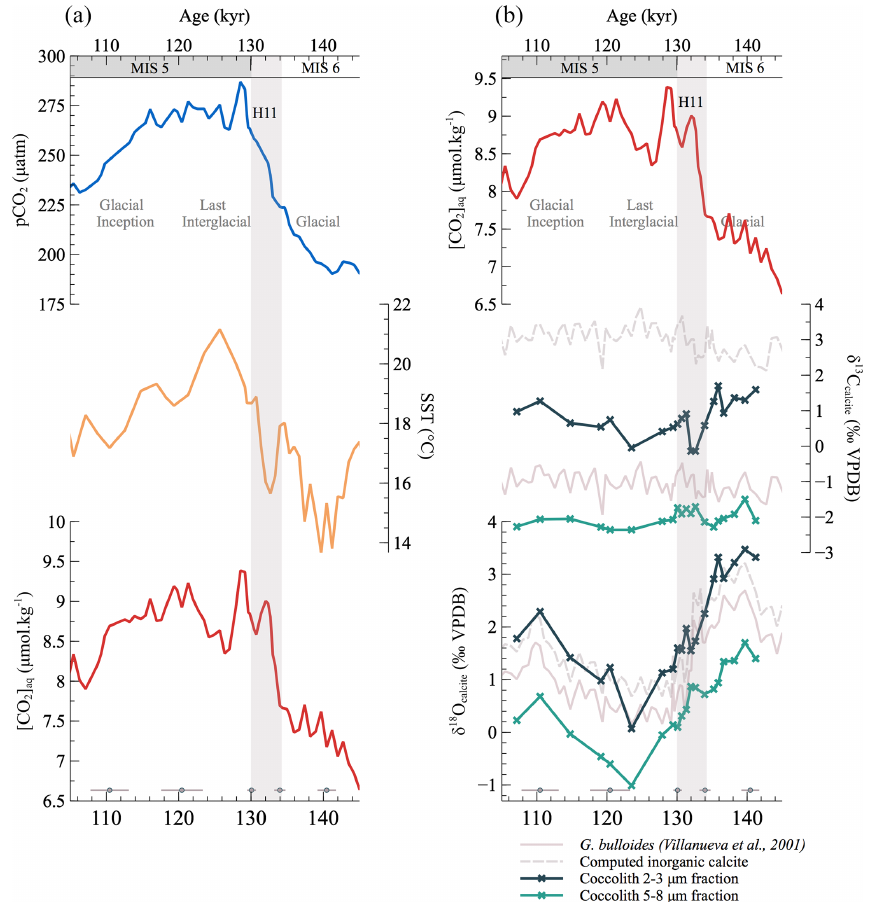
Figure 2. Deglacial changes in the isotopic composition of coccolith size fractions, sea surface temperatures and aqueous CO 2 concentra- tions. Panel (a) : the aqueous CO 2 curve is derived from the ice core pCO 2 (Bereiter et al., 2015) and sea surface temperature (SST) records from Calvo et al. (2001) (see “Material and methods” section). Panel (b) : changes in coccolith δ 13 C and δ 18 O per size fraction considered across the interval. Also reported are the values of the isotopic composition of foraminifera G. bulloides calcite (Villanueva et al., 2001) from which we tentatively derived values for the δ 13 C and δ 18 O of inorganic calcite (see “Material and methods” section). Age uncertainties over the interval of study are shown (bottom gray